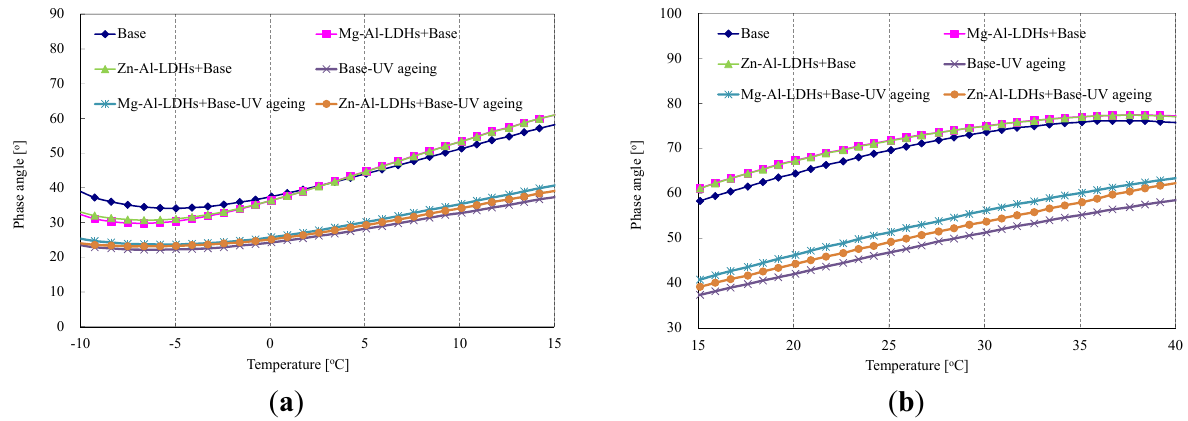
Figure 4. Effect of different LDHs on phase angle of SK-90 bitumen before and after UV aging.